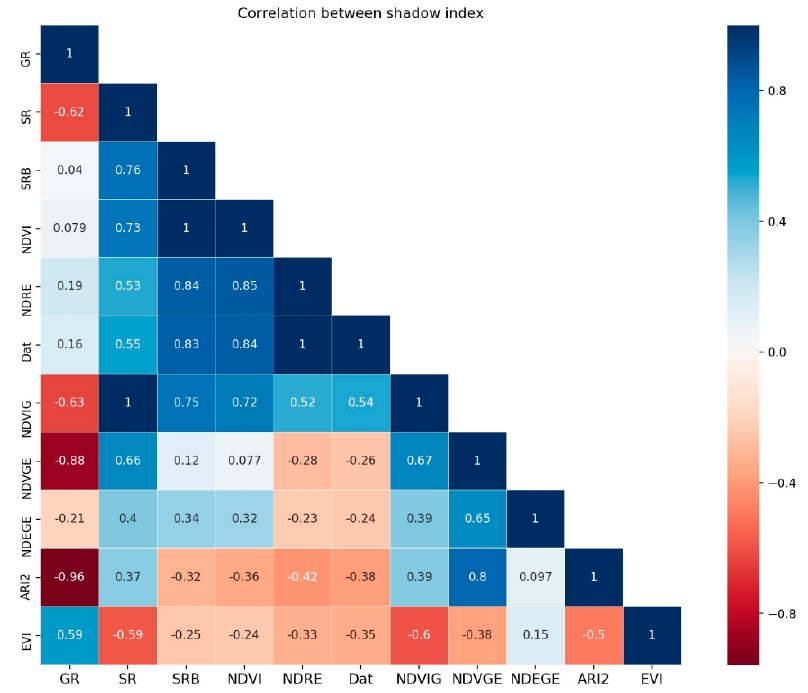
Figure 4. The VI correlation coefficient of different vegetation